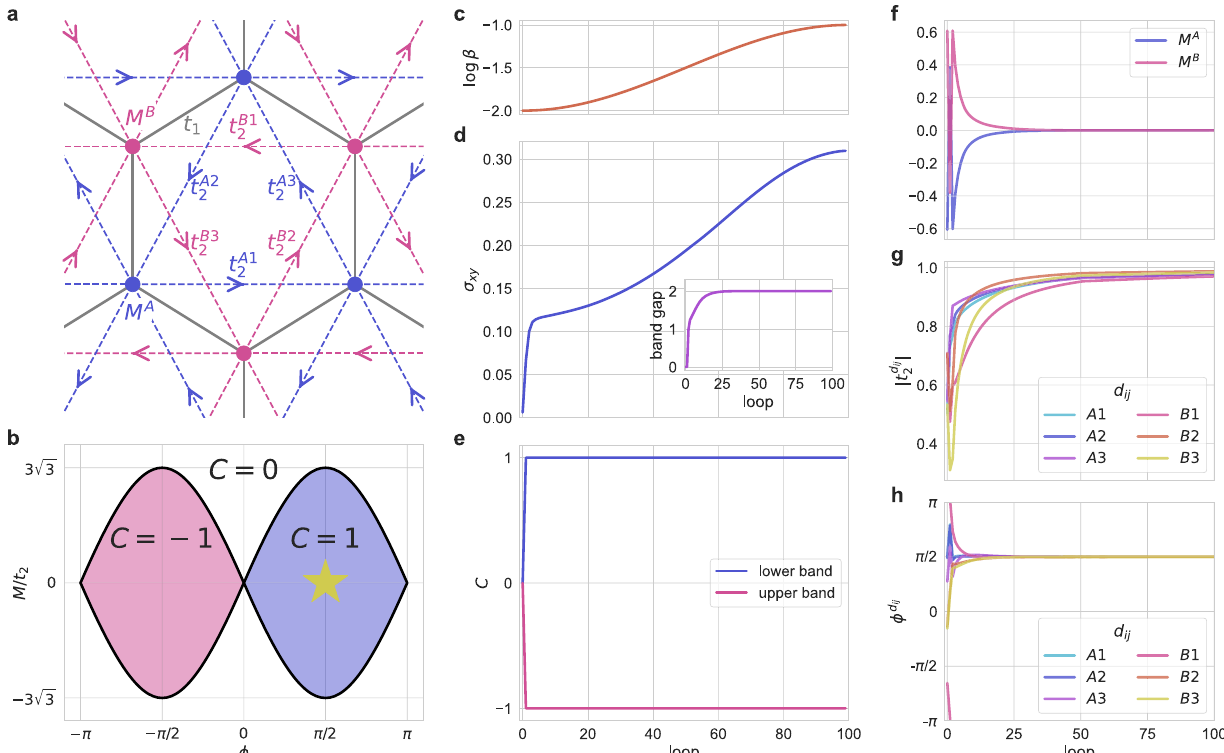
Fig. 2 Automatic construction of the Haldane model. a A tight-binding model on a honeycomb lattice in Eq. (1). There are 14 parameters including on-site potential M a i and the amplitudes and phases of the second-neighbor hopping t d ij , where a i ∈ { A , B } is the index of the sub-lattice and 2 d ij ∈ { A 1, A 2, A 3, B 1, B 2, B 3} is the direction of the hopping. The nearest-neighbor hopping t fi xed to 1. b Phase diagram of the Haldane model, where 1 is M A = + M , M B = − M , t = 1, and t d ij ¼ t 2 exp ð i ϕ Þ . There are two topologically nontrivial phases with nonzero Chern numbers C = ±1. The yellow star 1 2 represents where our framework reaches after the convergence. c , Schedule of log β , where β is the inverse temperature. d , e Changes of the Hall conductivity σ xy ( d ) and the Chern numbers C for the two bands ( e ) through the optimization process. The inset in d shows the change of the band gap. j ( g ), and ϕ d ij ( h ), where ϕ d ij is the phase of t d ij f – h Changes of the parameters: M a i ( f ), j t d ij 2 2